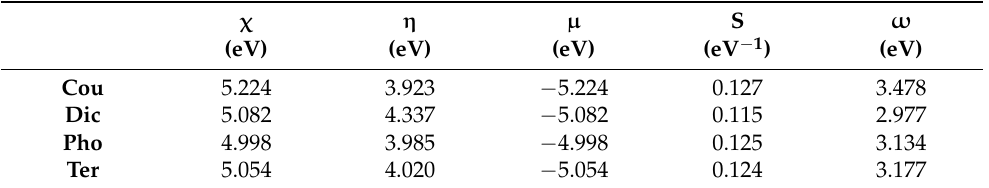
Table 3. The HSAB reactivity descriptors of organophosphorus pesticides ( Cou , Dic , Pho and Ter ) in the present